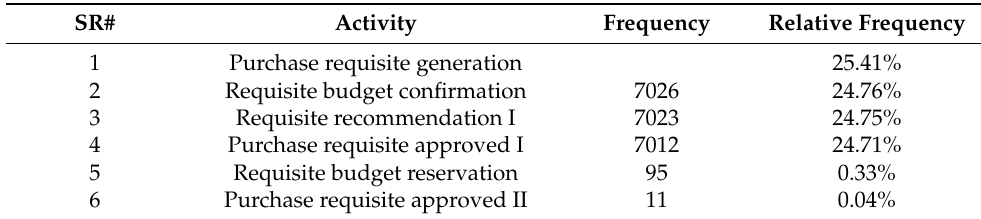
Table 6. Activity statistics after removing repetition of an activity.